Question: Give a one-sentence summary of this figure.
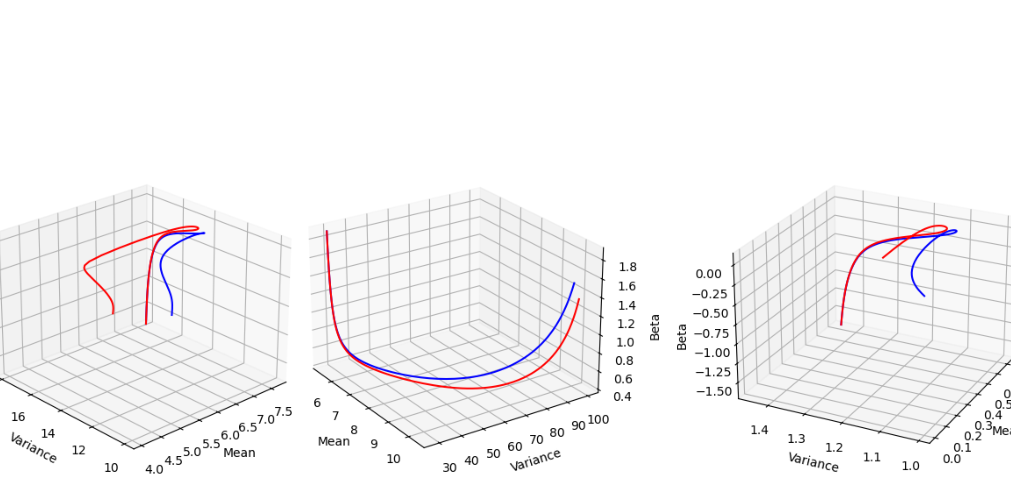
Answer: Geodesic curves and their time reversed versions obtained by the proposed iterative MCMC based fourth-order Runge-Kutta algorithm regarding the rows seven, eight and nine of Table 2) The blue curve denotes the orignal geodesic and the red curve denotes its time reversed version.